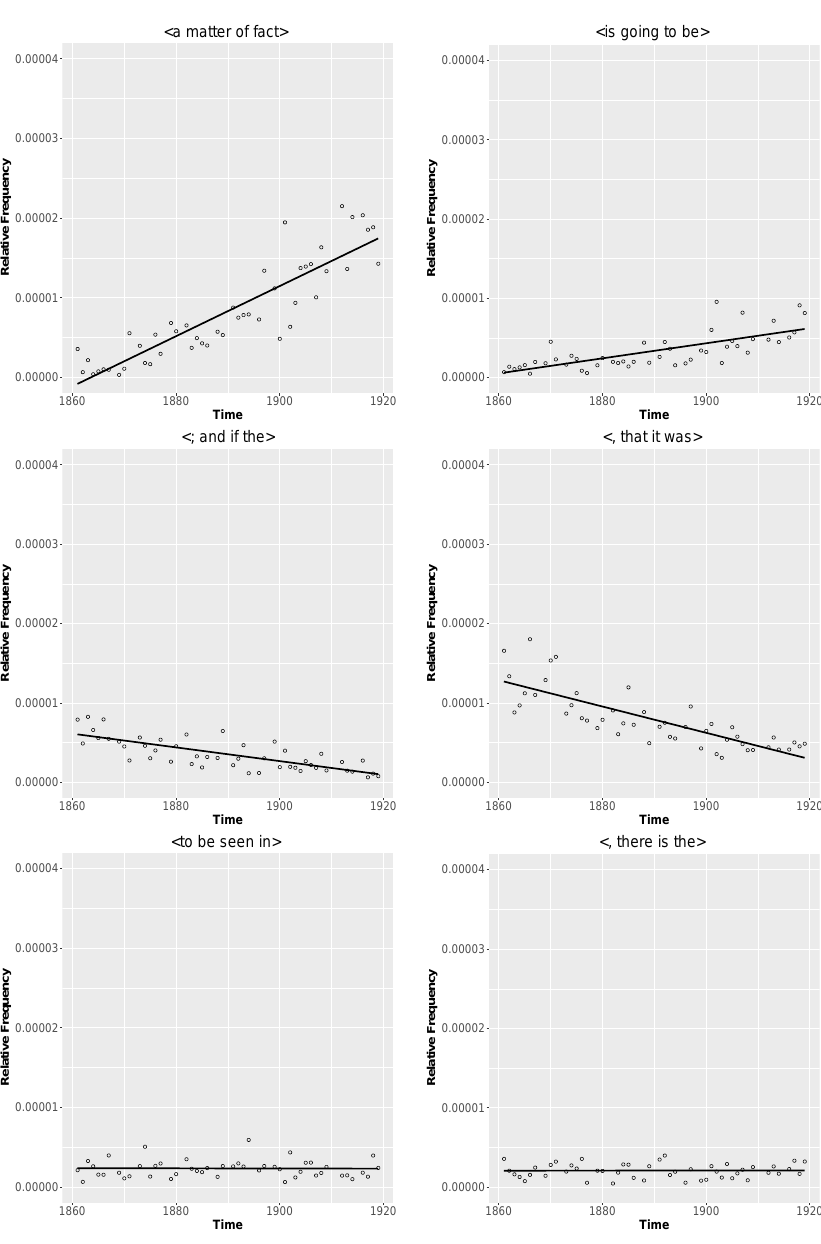
Figure 3: Reference corpus: relative frequency of several syntactic word tetra- grams, exhibiting ‘increase’, ‘decrease’, or ‘no perceptible change’ over time